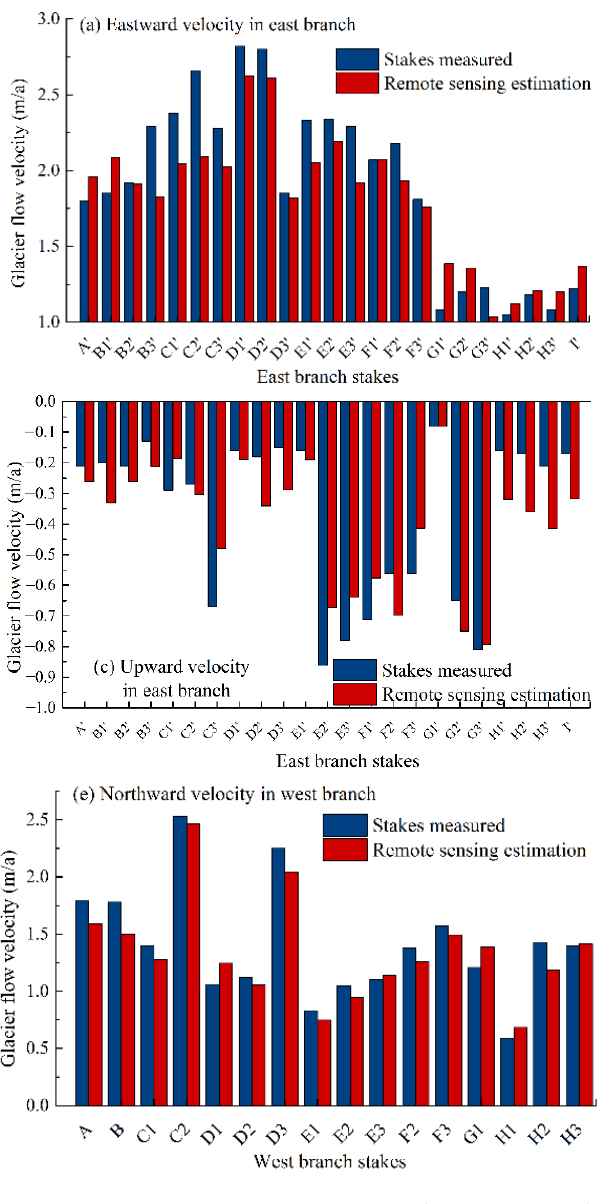
Figure 10. The comparison between the estimated glacier velocity by remote sensing and the measured glacier velocity at the stakes. ( a – c ) show the velocity in the east branch. ( d – f ) show the velocity in the west branch.